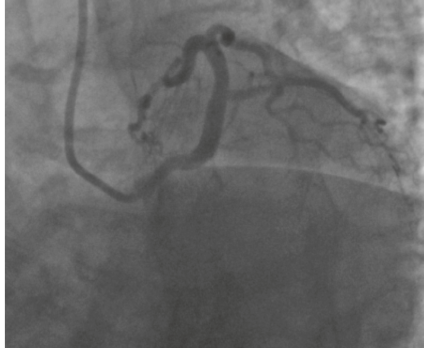
Figure 2: LAO caudal view showing absent left circumflex (LCX).